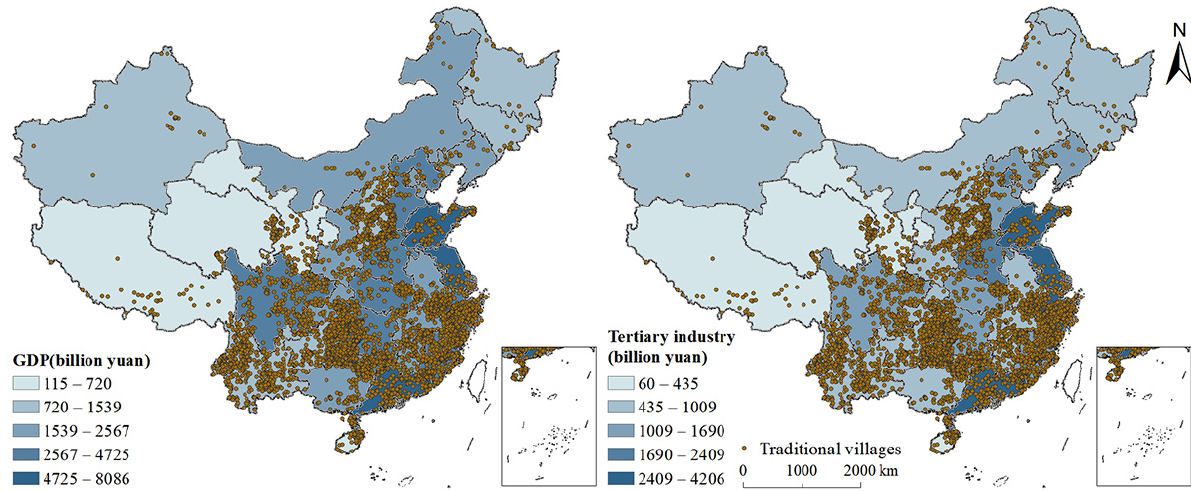
Figure 4. Spatial relationships between the distribution of traditional villages and economy.